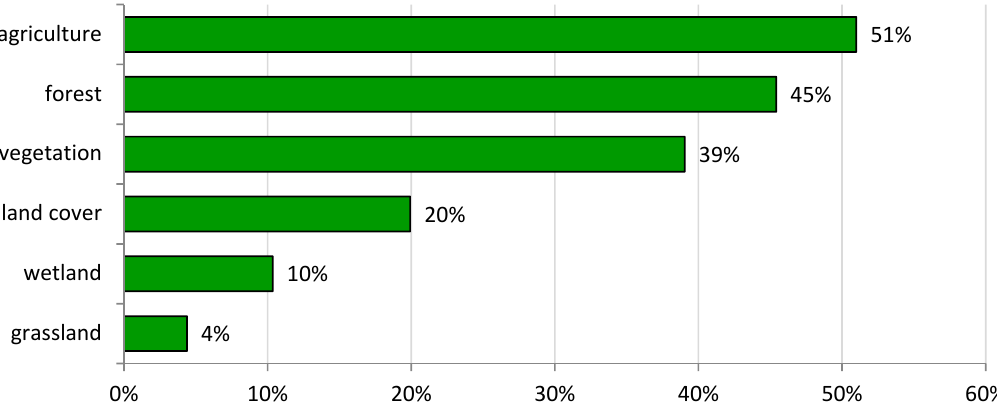
Figure 5. Thematic fields of biosphere-related TerraSAR-X proposals, sorted by frequency, specifically addressing agriculture, forest, wetland and grassland issues or, more generally, vegetation and land cover.